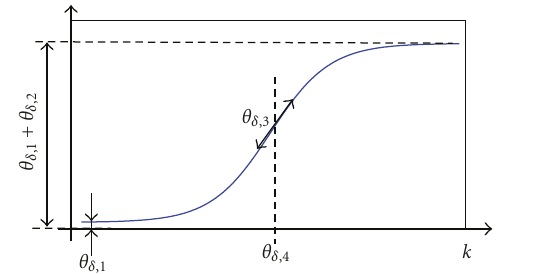
Figure 2: Graphic representation of the sigmoid parameters.